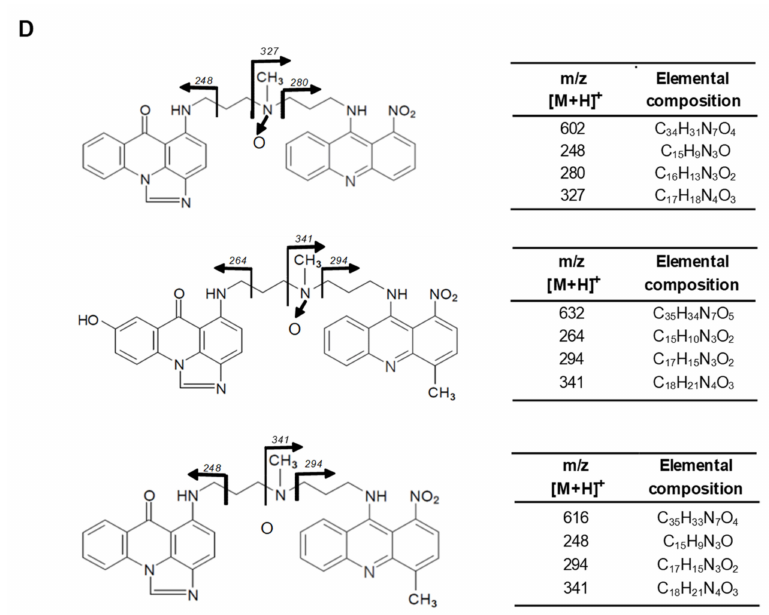
Figure 7. HPLC, ESI-MS and ESI-MS/MS analysis of the reaction mixture after 90 min incubations of 0.01 mM ( A ) C-2028, ( B ) C-2045 and ( C ) C-2053 with 0.5 mg/mL of FMO1. 0.3 mM NADPH was applied as the cofactor; ( D ) structure identification.